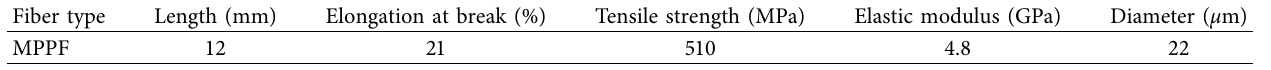
Table 2: Values of basic parameters for modified polypropylene fiber.